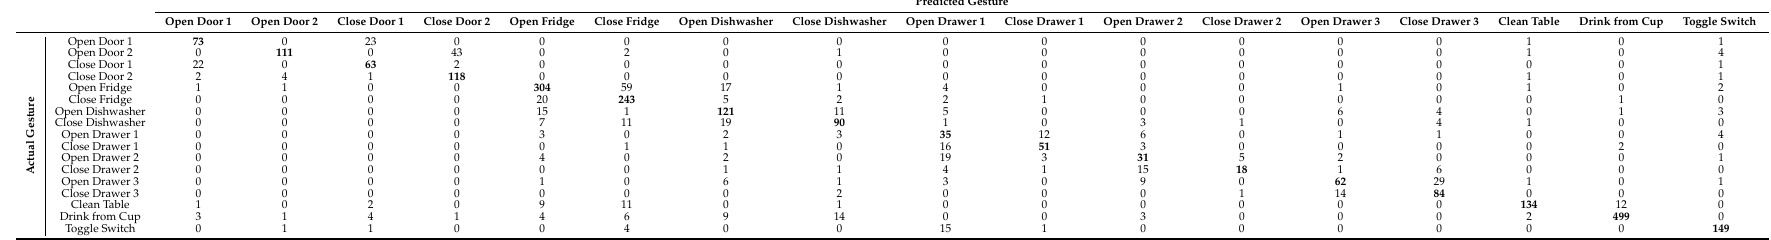
Table 8. Confusion matrix for OPPORTUNITY dataset using the baseline CNN (without the Null